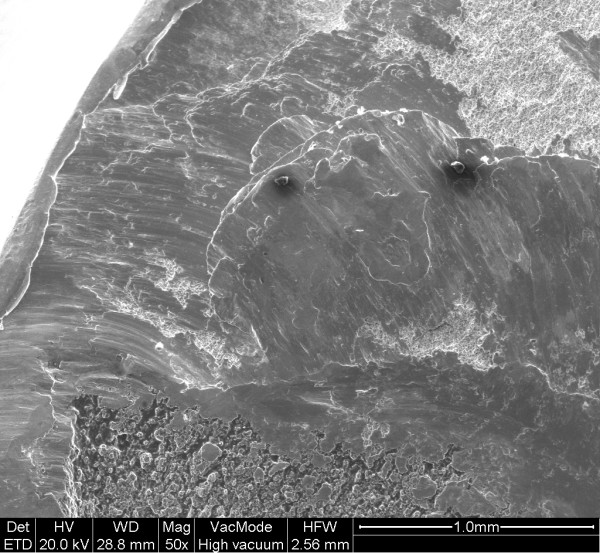
Shear lip (region b).